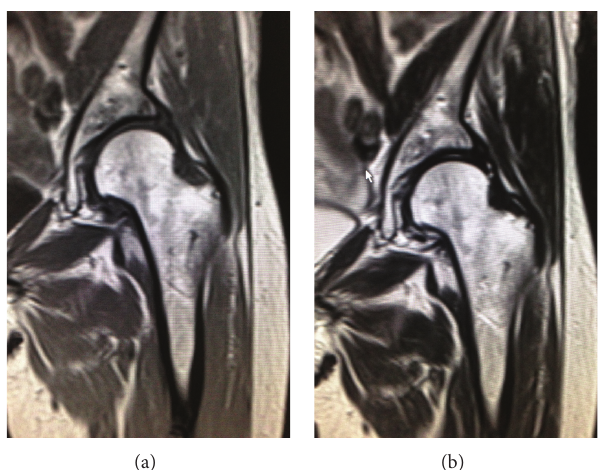
Figure 3: MRI of T1 weighted image (a) and T2 weight image (b) showed no abnormality of the left hip.